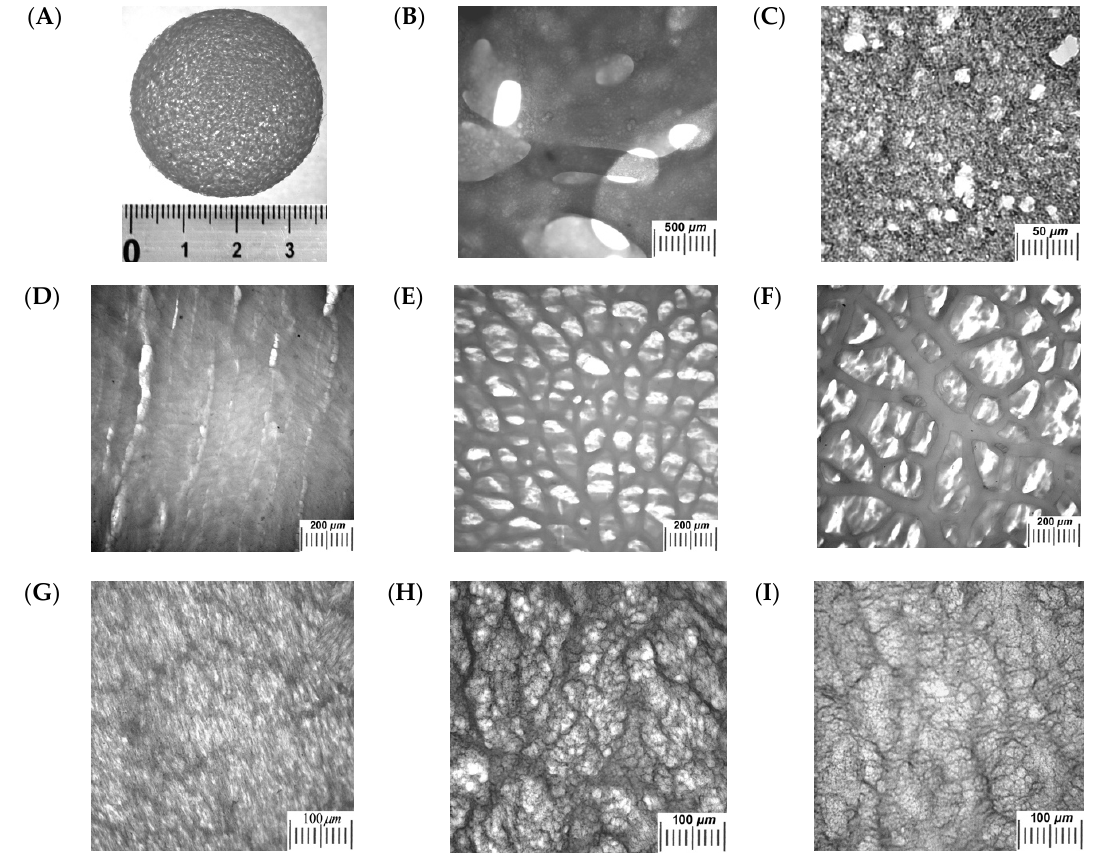
Figure 2. Macroporous morphology of the PVA cryogels prepared by the combination of the cryotropic. gel-formation and the additional phase-transformation processes: ( A – C ) Respectively, the appearance of the stained with Congo red 2-mm-thick disk ( 68 , Table 1) prepared by freezing ( − 30 ◦ C / 0.5 h and then − 5 ◦ C / 12 h) of the mixed solution containing PVA (7 wt.%) and gum arabic (7 wt.%) and the optical microscopy images of this gel material under different magnifications. ( D – F ) PVA-based cryogels ( 72 , Table 1) formed by freezing ( − 11.6 ◦ C / 12 h) of the DMSO solutions of the polymer without ( D ) and with the additives of methanol in concentration of 1.70 mol / L ( E ) and 2.55 mol / L ( F ) (10- µ m-thick thin section stained with Congo red; transmission optical microscope). ( G – I ) PVA-based cryogels ( 62 , Table 1) formed